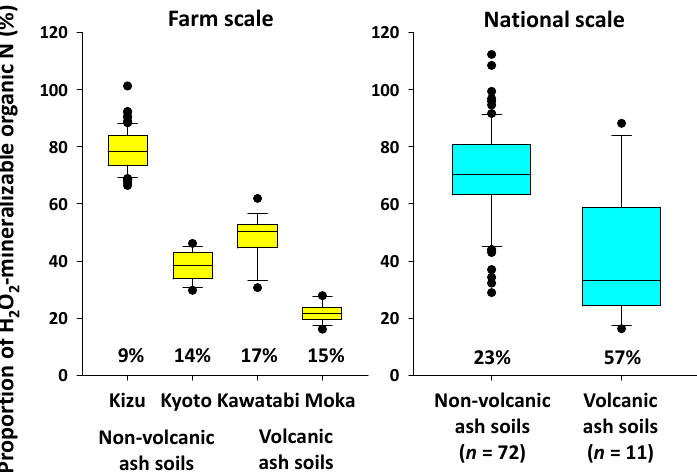
Figure 6. Box plot of the proportion of H 2 O 2 -mineralizable organic N in total N. Data for the national-scale samples are cited from [9]. The horizontal line in each box represents the median. The lower and upper limits of each box are the 25th and 75th percentiles, and the lower and upper whiskers represent the 10th and 90th percentiles. The values below the box plot indicate the CV values for each group.